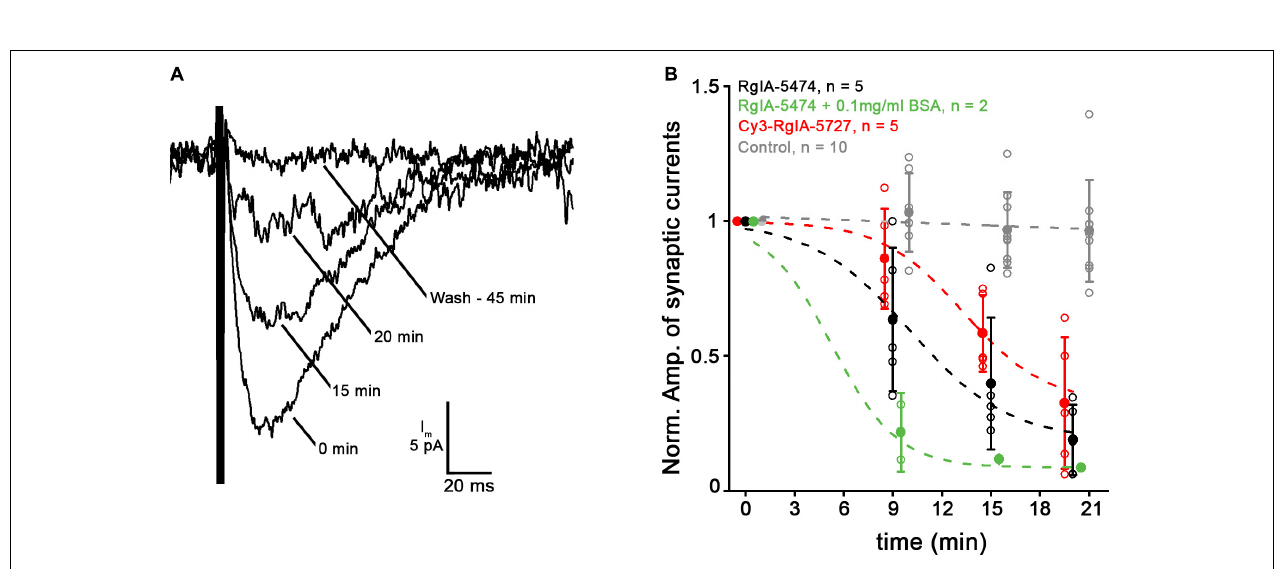
FIGURE 9 | Application of 10 nM Cy3-RgIA-5727 or RgIA-5474 gradually reduced the amplitude of efferent postsynaptic currents. (A) Synaptic current recorded at –90 mV in a P9 IHC during a 1 Hz train of 100 shocks. Each response is the average response at the indicated time point as Cy3-RgIA-5727 spread through the tissue. After washing out toxin for 45 min there was no recovery. Recordings exemplify results obtained from five IHCs from five mice. (B) Reduction of efferent postsynaptic current (normalized to initial pre-block value) over time in the presence of 10 nM RgIA-5474 (black) or 10 nM Cy3-RgIA-5727 (red). All data points + A 2 , where A 1 = initial value, A 2 = final value, collected at 9, 15, 20 min but displaced horizontally for clarity. Experimental data fitted with y = A 1 − A 2 1 + e ( x − x 0 )/ dx X 0 = center value, dx = time constant. Control data from 10 other IHCs not subject to blockers (gray) are fit with a straight line. Blocked data significantly different from control. But there was no significant difference in time course or degree of block at 20 min between RgIA-5474 and Cy3-RgIA-5727. Inclusion of 0.1 mg/ml bovine serum albumin (BSA) prevented surface absorption of peptide and significantly accelerated block onset (green).